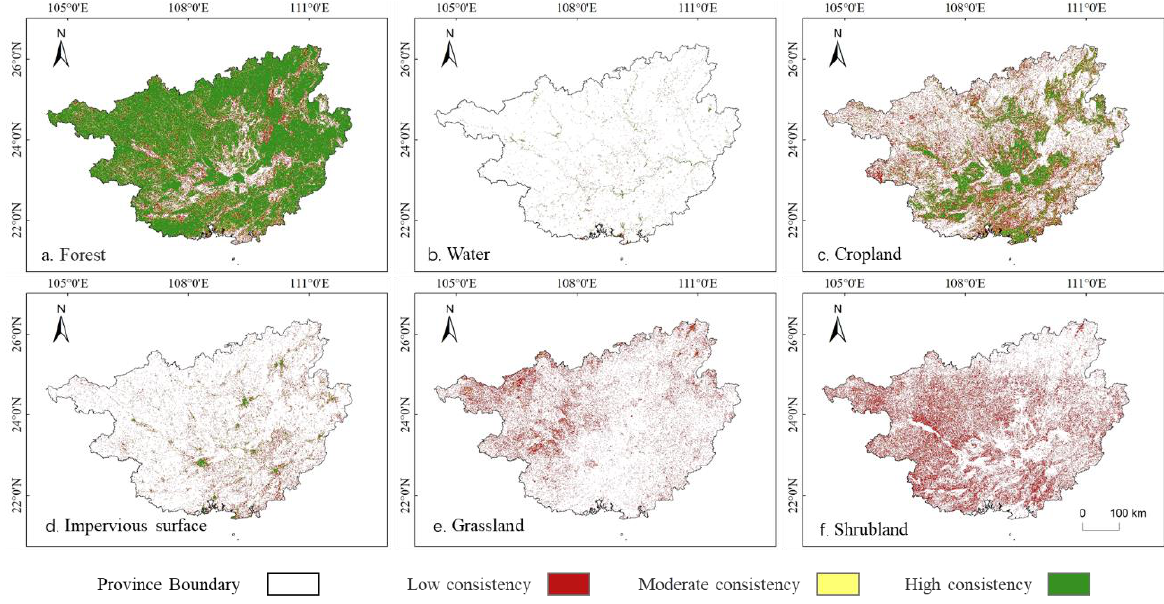
Figure 11. Results of spatial consistency analysis for major land cover types in Guangxi.